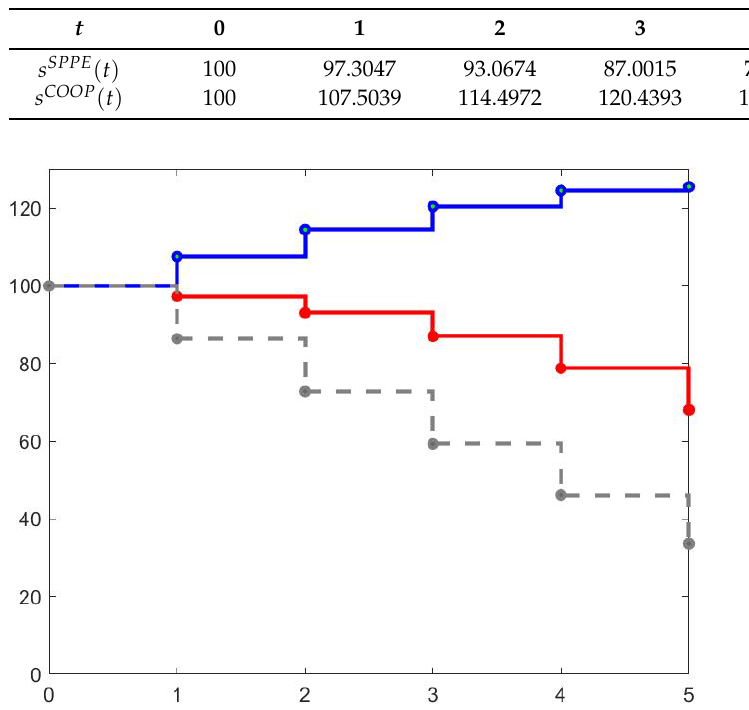
Figure 1. SPPE (red) and cooperative (blue) state trajectories in a bicriteria game. NE (dotted) trajectory in a unicriterion